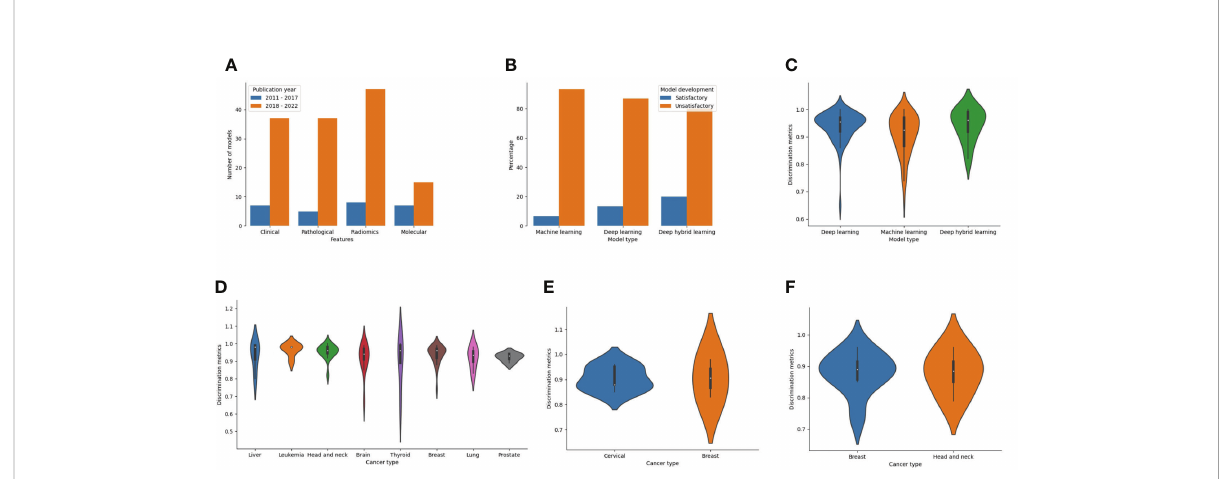
FIGURE 6 Bar and violin plots evaluating the methods used for model development and summary model performances (A) Plot of features used for model construction by publication year (B) Plot of ML technique by the rating of model development processes (C) Plot showing summary accuracy estimates for the three different ML techniques (D) Plot showing summary accuracy for ML-based models for diagnosis according to the cancer types (E) Plot showing summary accuracy for ML-based models for cancer screening according to the cancer types (F) Plot showing summary accuracy for ML-based models for cancer prognosis according to the cancer